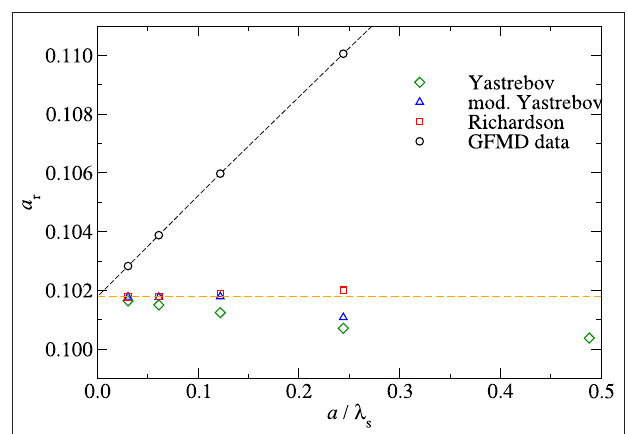
FIGURE 3 | Comparison of different extrapolation schemes for the relative a /λ s contact area a r to the continuum limit ε c 0 for an rpa surface ≡ → specified by H 0.8, p ∗ 0.05, λ r / L 0.5, and λ s / L 0.008. In the = = = = modified Yastrevob extrapolation, the prefactor α in Equation (22) was chosen such that the extrapolated contact area at a discretization a λ s and at 2 a λ s gave the same estimate for the contact area. Dashed lines are drawn to guide the